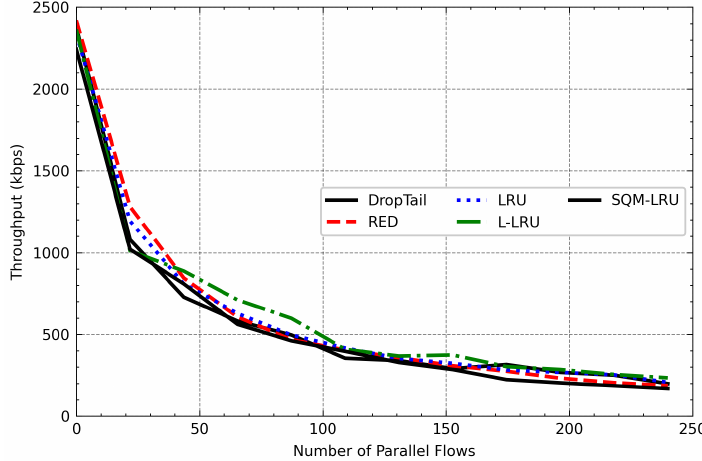
Figure 15. CBR throughput varies with the number of parallel